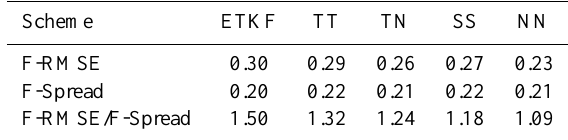
Table 3. Similar to Table 2, but with F =